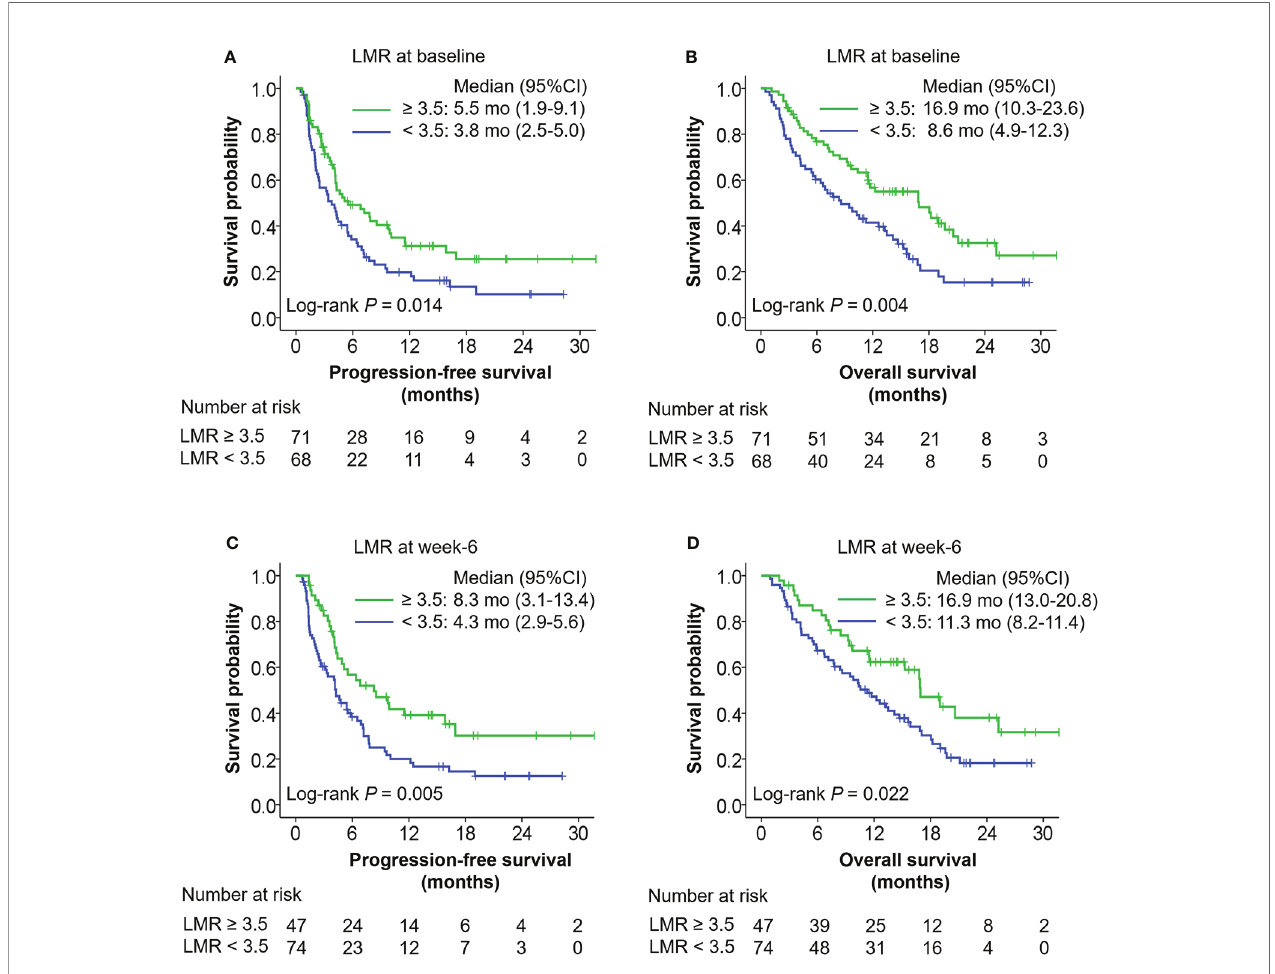
FIGURE 1 | Kaplan-Meier curves of progression-free survival (PFS) and overall survival (OS) according to LMR at baseline (A, B) or week 6 (C, D) . The P values were calculated using log-rank test